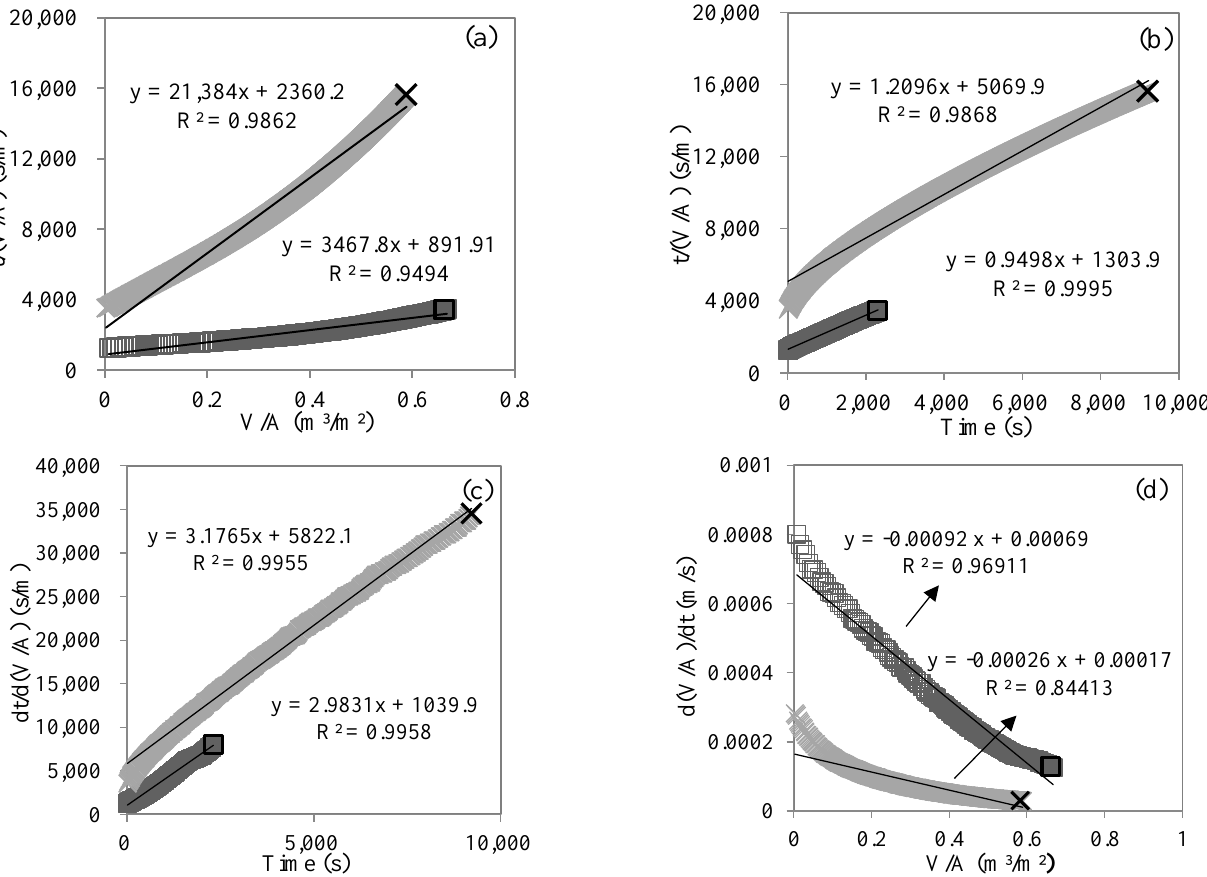
Figure 7. Linear fitting of single models, including cake layer ( a ), standard blocking ( b ), intermediate blocking ( c ), and complete blocking ( d ) for MF process during gradient filtration of low- ( □ ) and high-concentration ( × ) SWW. Table 2. R 2 of single model fitting for gradient filtration of SWW.